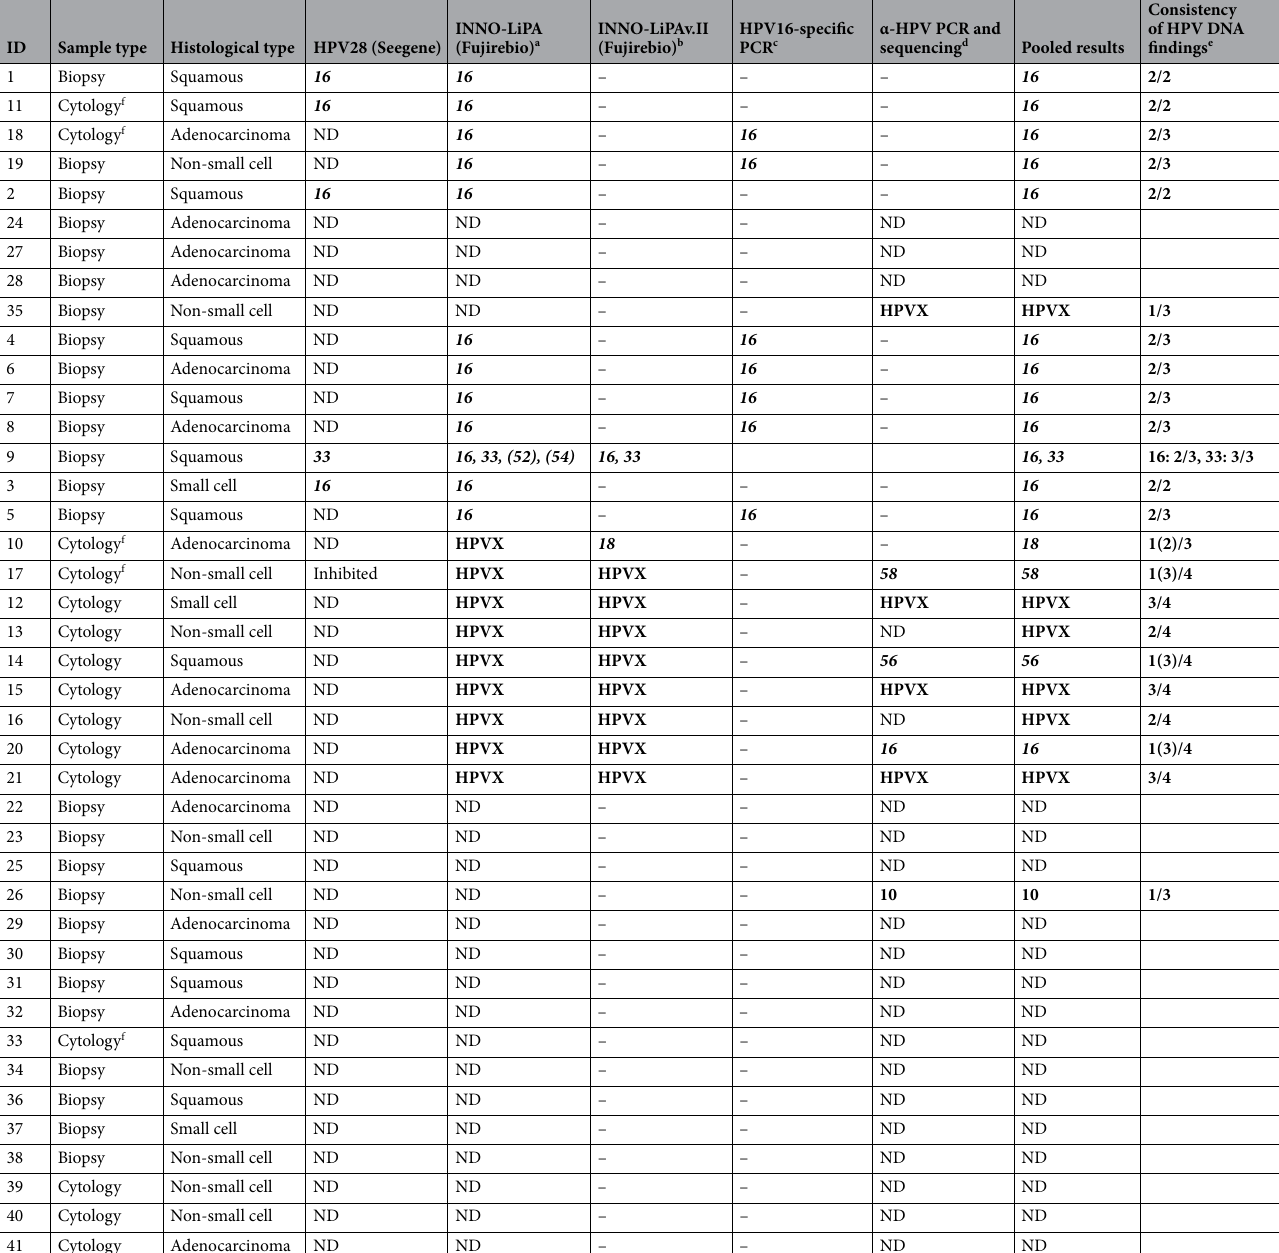
Table 2. HPV results according to the different detection methods used. ND not detected, – not performed, High-risk HPV types are marked in bold italics 47 . a Due to INNO-LiPA band patterns obtained, the presence of HPV types in parentheses could not be confirmed. b This assay was used to resolve non-typeable INNO-LiPA results. c This assay was used to test specimens for which the HPV28 and INNO-LiPA assays yielded discordant results for HPV16. d This strategy was used to genotype specimens whenever the INNO-LiPA assays yielded an HPVX, or to assess HPV DNA presence in specimens that were identified as negative by commercial assays. e Number of assays with a positive result for a given HPV type among all assays performed. When a specific genotype was called by one of the assays, but a non-typeable result (HPVX) was obtained by the other assays, the numbers of positive but non-typeable results are given in parentheses. f Cytology paraffin